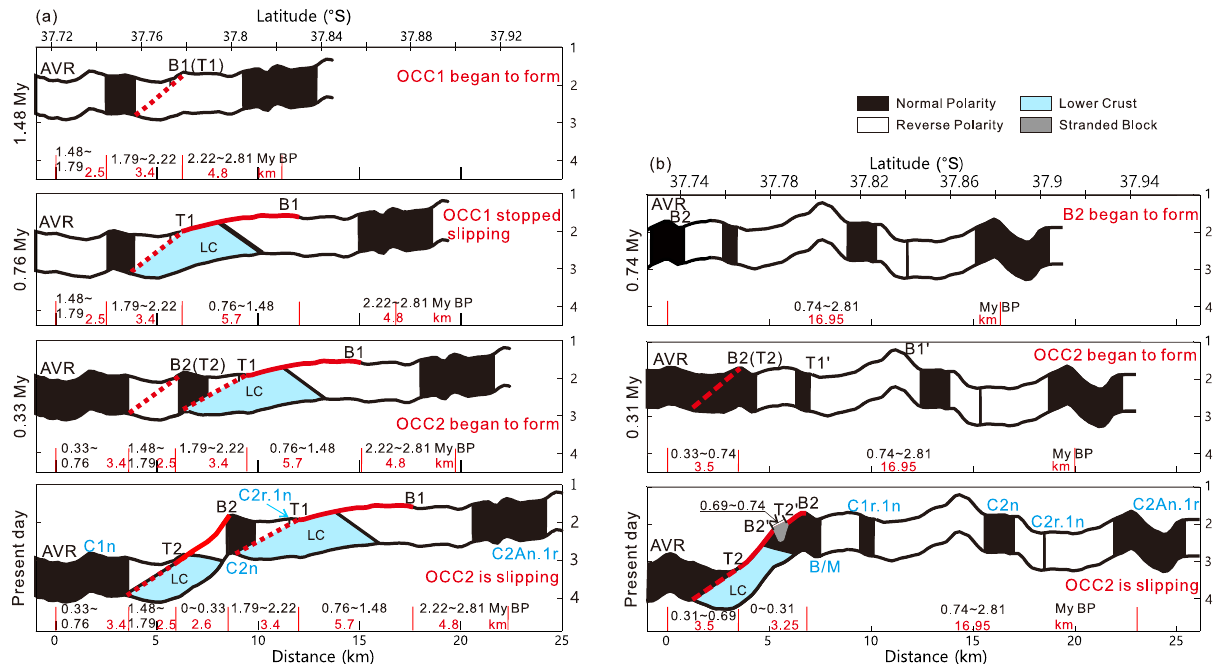
Fig. 6 The evolutionary history of the detachment faulting system with hydrothermal activity based on pro fi les L2 and L3. Only upper crustal section is shown with corresponding spreading rate along pro fi les and projected polarity zones. a Pro fi le L2 evolution shown from 1.48 Myr BP to present and b Pro fi le L3 evolution shown from 0.74 Myr BP to present. Also shown are the breakaway B1 and termination T1 of OCC1 and the breakaway B2 and termination T2 of OCC2. Red lines represent the OCC slip surfaces, other lines are accretionary terrain, and gray area represents the stranded block on OCC2. LC refers to lower crust exhumed by OCC1 and OCC2 and presumed to be less magnetic than the upper crustal extrusive section. Slip is assumed to be continuous along the OCC fault surfaces when they are formed until they terminate (i.e. no stop and start behavior). OCCs are assumed to nucleate off-axis approx. 3 – 6 km from the axis of spreading (NVZ). Topography is only approximate and may not re fl ect past topographic